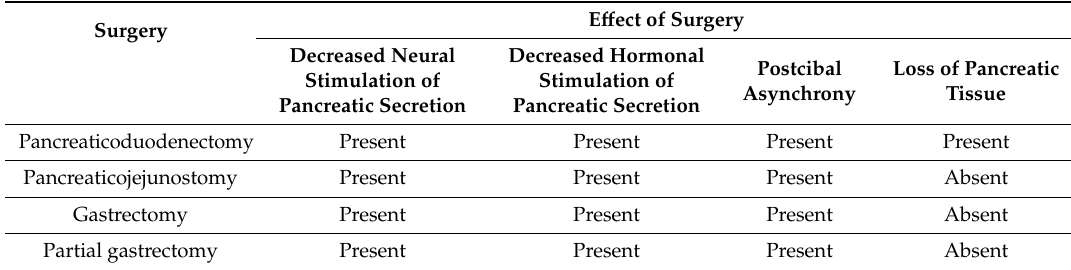
Table 3. Pathogenic mechanisms involved in surgical conditions that lead to pancreatic exocrine insu ffi